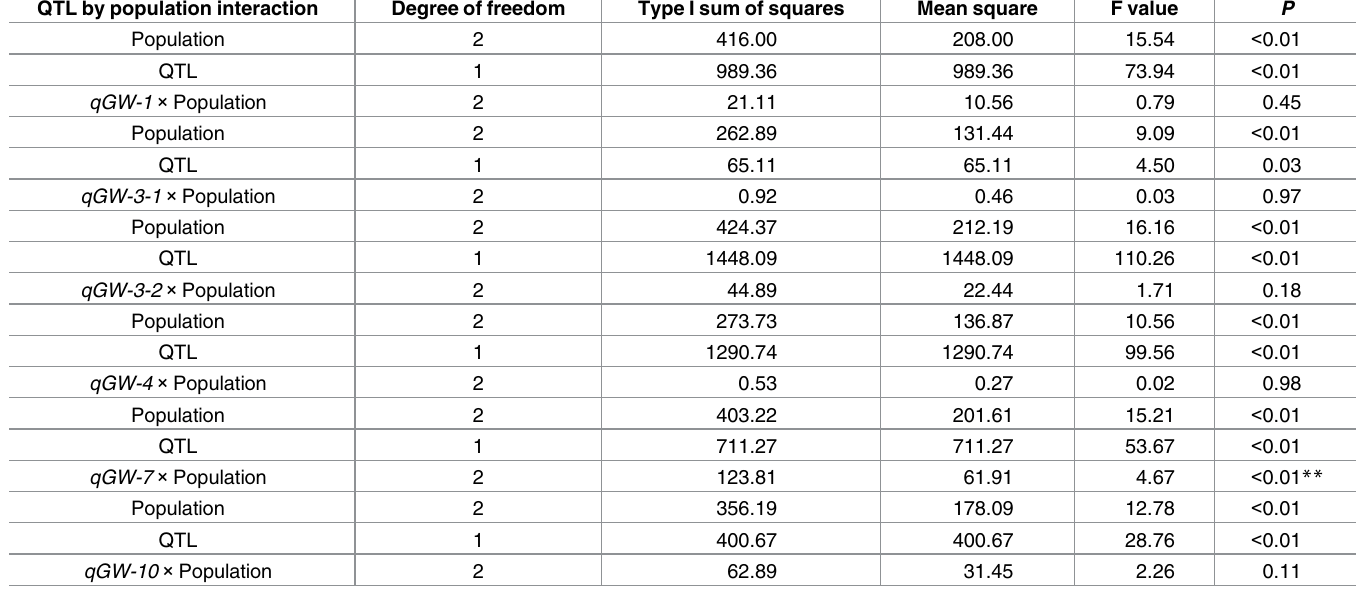
** Values were highly significant at P <